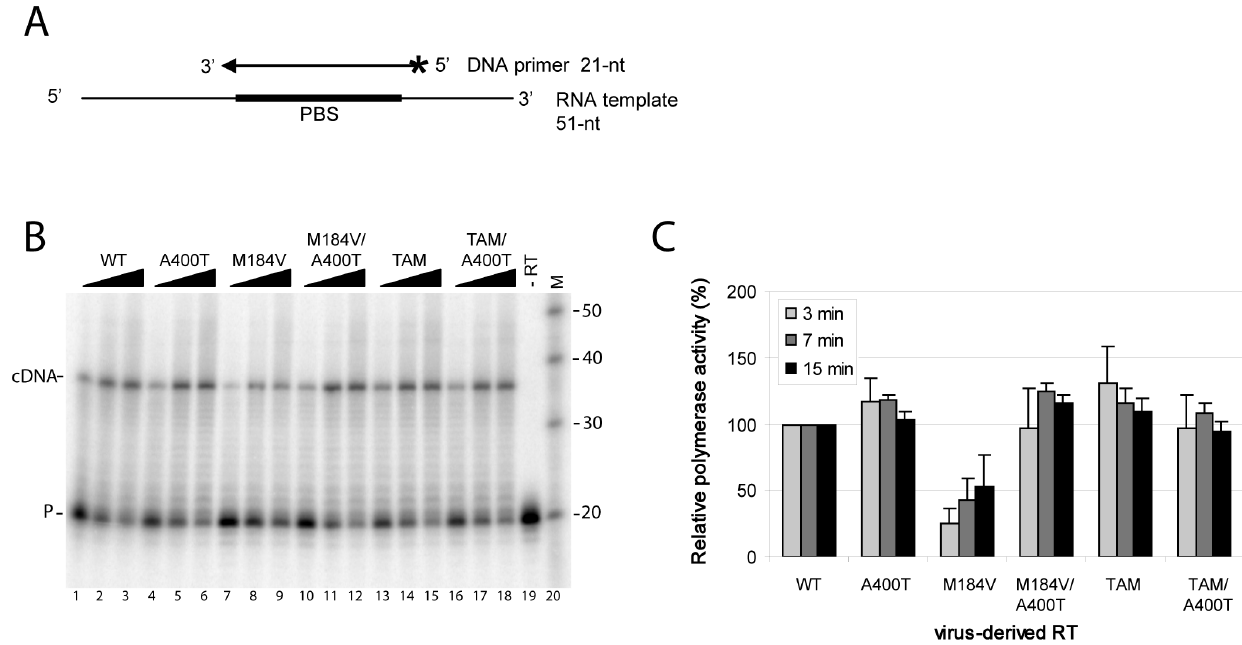
Figure 2. DNA polymerase activity of virus-derived RT enzymes containing substitution A400T. (A) DNA polymerase activity was measured using a 51-nt RNA template, representing the HIV-1 primer binding site (PBS) with flanking sequences. A 21-nt DNA primer complementary to the PBS was 5 9 -end-labeled (asterisk), and heat-annealed onto the RNA template. Extension of the primer by RT will result in a 38-nt labeled cDNA product. (B) The RNA template/DNA primer complex was incubated with the different virion-derived RTs in the presence of dNTPs. Formation of the cDNA product (cDNA) was monitored after 3, 7 and 15 min incubation. A control reaction was performed in the absence of RT (lane 19) showing only the labeled primer (P). (C) The amount of cDNA production was quantified in three independent experiments. Plotted is the average cDNA production with standard deviation (error bars). The polymerase activity of the wild-type virus-derived RT was set at 100%.